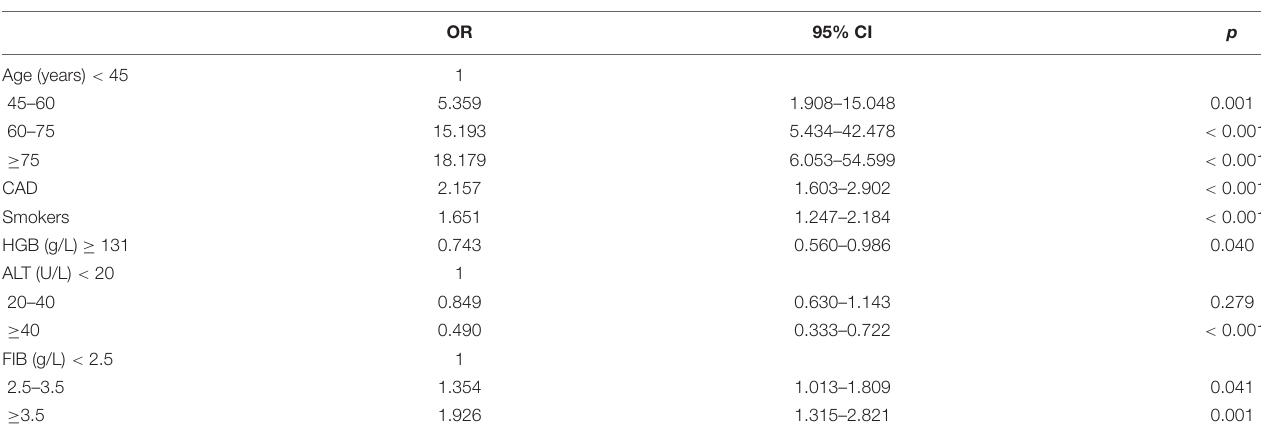
TABLE 4 | Logistic regression analysis for influencing factors for